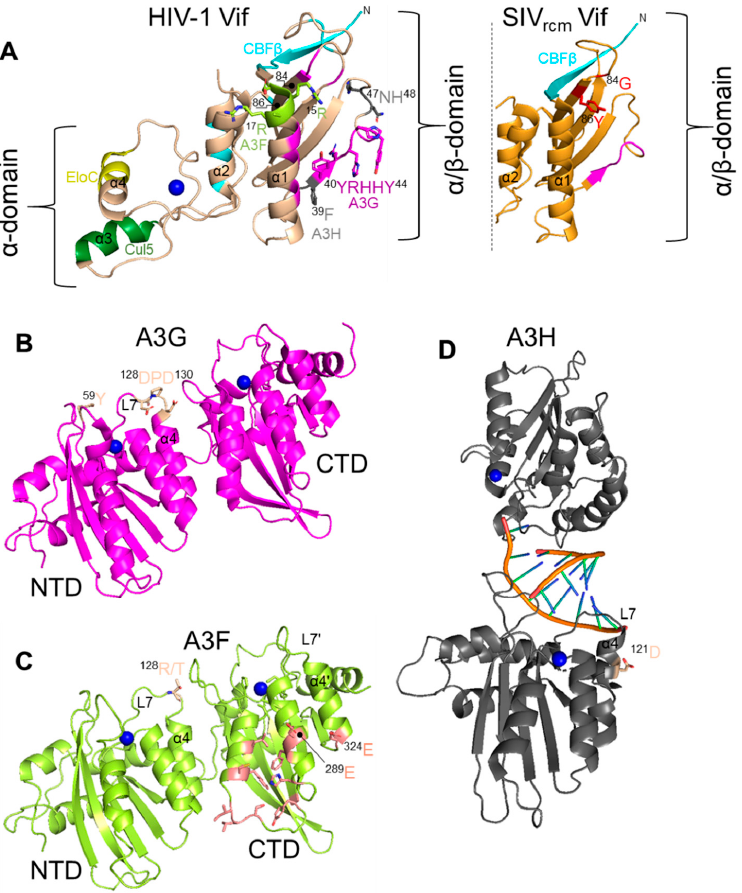
Figure 2. Interaction residues for Vif and APOBEC3s. ( A ) HIV-1 Vif (PDB: 4N9F) has two domains on either side of a bound Zinc (blue). The α -domain contains two alpha helices that mediate two separate interactions with EloC (yellow) and Cul5 (dark green). The N-terminal α / β -domain consists of a five stranded β -sheet, a discontinuous β -strand and three α -helices. The α / β -domain contains the binding interface for CBF β (cyan) and A3 enzymes. The magenta residues interact with A3G, lime green interact with A3F, and grey interact with A3H. This surface for interacting with A3s is conserved in the hominid lineage. Through mutational and structural studies it was found that OWM additionally use residues 83 to 86. In the SIV rcm Vif structure (partial structure shown on right, PDB: 6P59) residues 83 to 86 are partially on Loop 5, but on HIV-1 Vif they are on a β -strand. The 84 and 86 are key determinants for OWM SIV antagonism of A3F and A3G, respectively. Thus, the OWM SIV Vifs appear to still use the same general interface as hominid SIV/HIV Vifs. ( B – D ) A3 enzymes have a basic structure in each ZDD that is composed of a five-stranded β -sheet core surrounded by six α -helices. Zinc atoms are shown as blue spheres. ( B ) Rhesus Macaque A3G (PDB: 6P40) is shown. A3G interacts with Vif on the NTD using three primary amino acids from 128–130 on loop 7 (L7). The human A3G amino acids are denoted in large orange letters. These three amino acids most often differ between species. Amino acid 59 is adjacent to the DPD motif and was found to be polymorphic between Sooty Mangabeys and Rhesus Macaque. ( C ) Model of Rhesus Macaque A3F generated from PDB: 6P40 using SWISS-MODEL [95]. HIV-1 Vif primarily interacts with human A3F on the CTD with residues E289 and E324 identified as major contact points. HIV-2 and SIV smm interact with human/sooty mangabey A3F on the NTD using residue 128. This is analogous to the region Vif interacts with A3G. ( D ) A3H (PDB: 6B0B) is an obligate dimer with dimerization mediated by a double-stranded RNA. The equivalent amino acid to A3G and A3F 128 is A3H 121. In A3H, this amino acid is on α -helix 4 (h4), rather than the adjacent loop 7 (L7). Human A3H Haplotype II is shown. Figures were made using PyMOL (the PyMOL Molecular Graphics System, Version 1.5.05, Shrödinger, LLC,